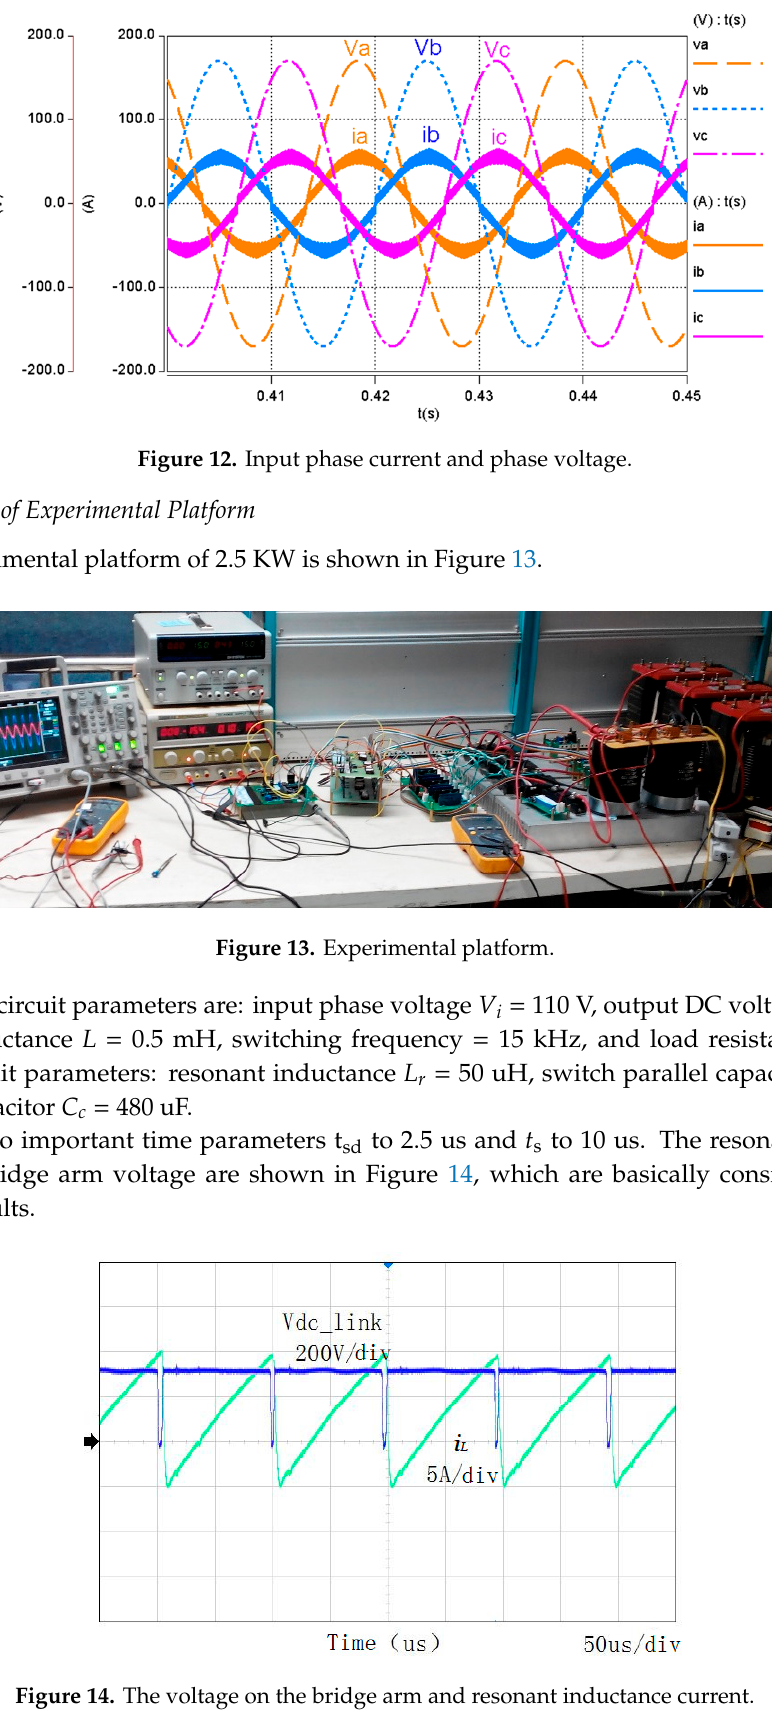
Figure 14. The voltage on the bridge arm and resonant inductance current.